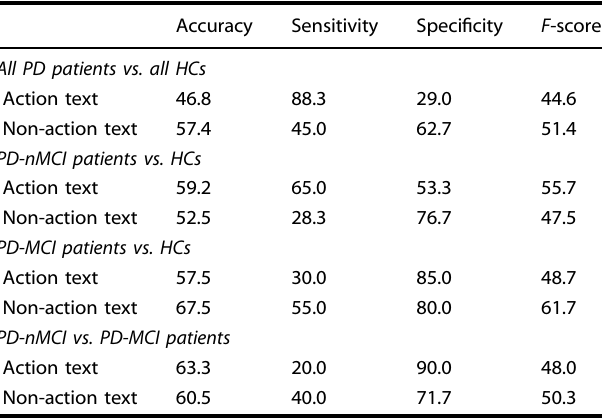
Table 2. GloVe embeddings: classi fi cation based on corpus-derived verb-to-verb semantic distance.